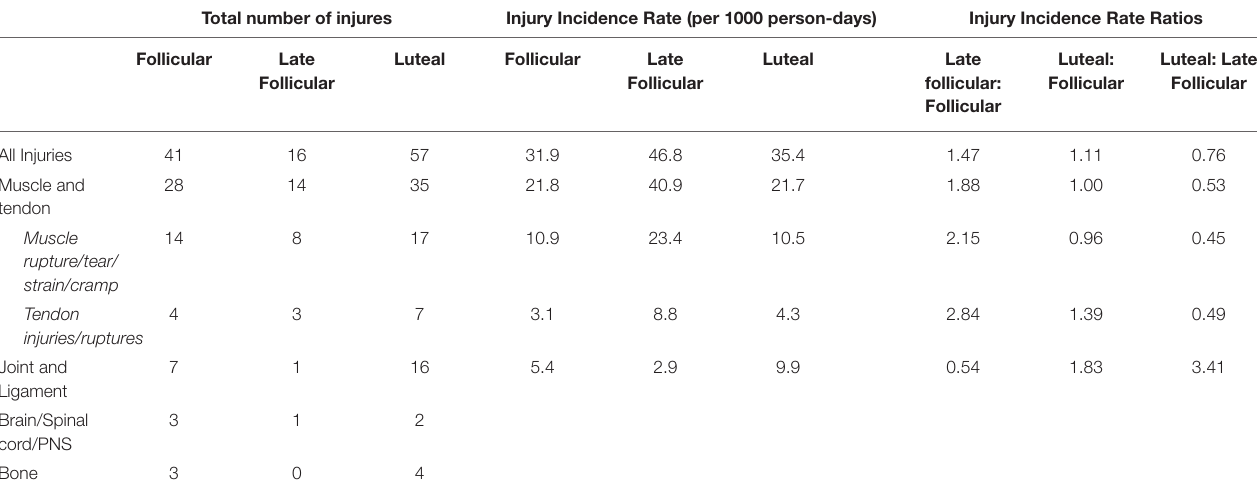
TABLE 1 | Number of injuries, injury incidence rates, and injury incidence rate ratios for all injuries and injuries separated by type and sub-type (italics) for eumenorrheic participants. Total number of injures Injury Incidence Rate (per 1000 person-days) Injury Incidence Rate Ratios Follicular Late Follicular